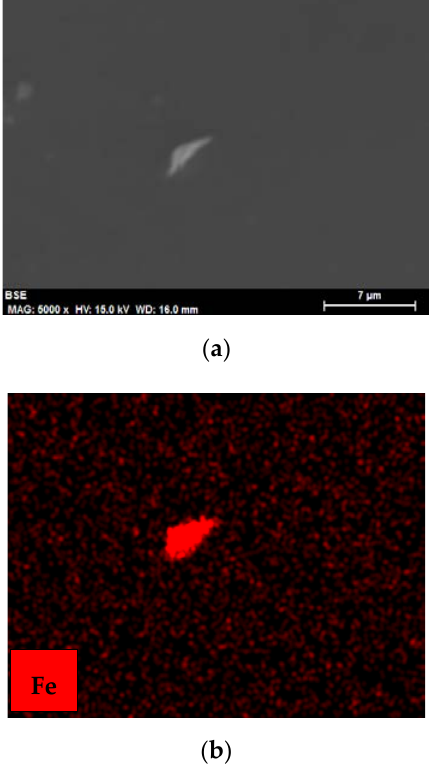
Figure10. ( a )BackscatteredSEMmicrographofweardebrisafterlubricationwithIL;( b Figure 10. ( a ) Backscattered SEM micrograph of wear debris after lubrication with IL; ( b ) Fe element map.